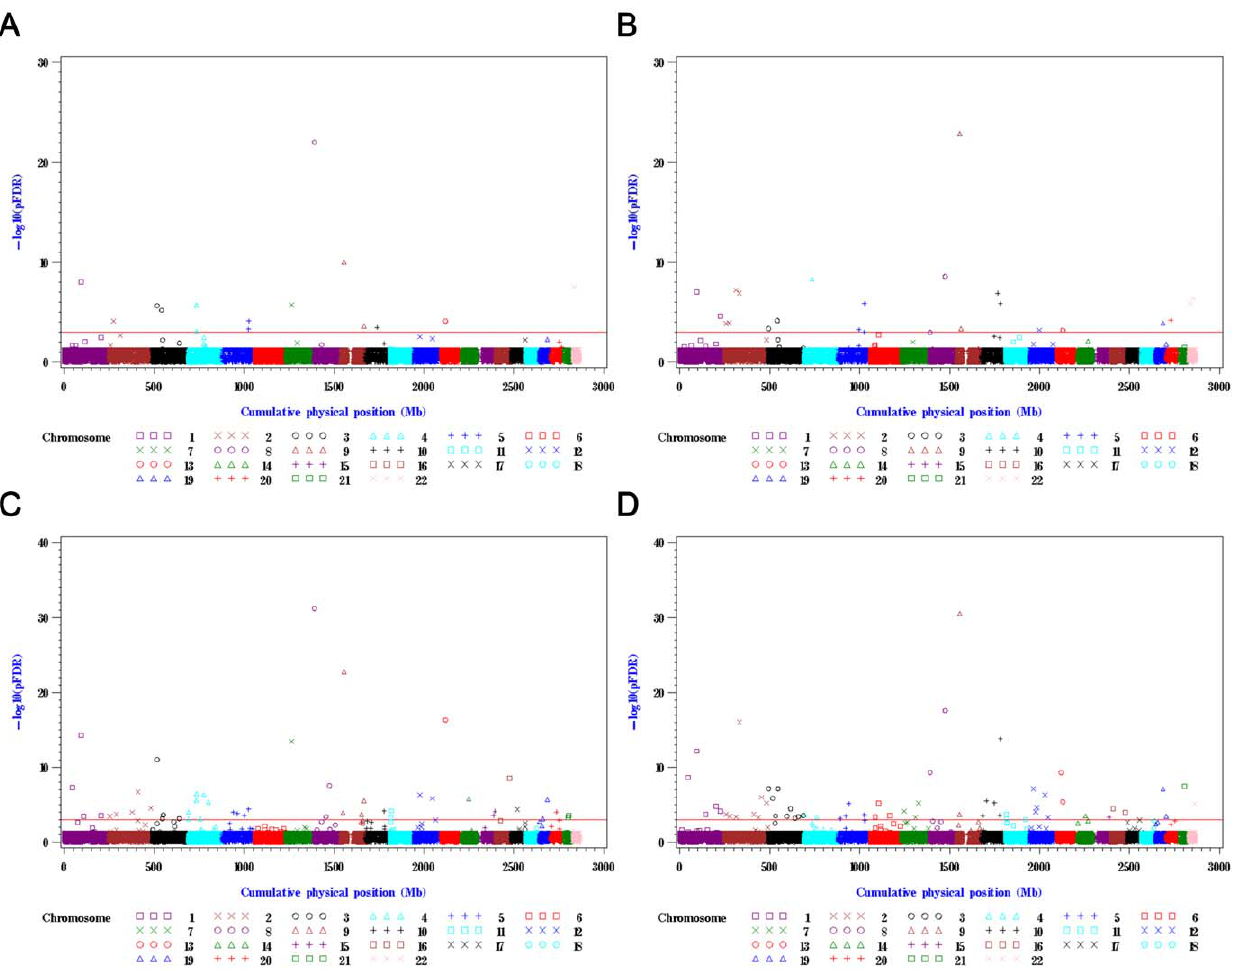
Figure 2. Gene-based association tests based on p-values from the four conditional logistic regression models. (A) model CLR N , (B) model CLR N,BMI , (C) model CLR C , and (D) model CLR C,BMI . In each figure, the vertical axis is the FDR-adjusted p-values ( 2 log 10 scale) of gene-based association tests, and the horizontal axis is cumulative physical position (Mb scale). The red reference line signifies pFDR=10 2 3 .